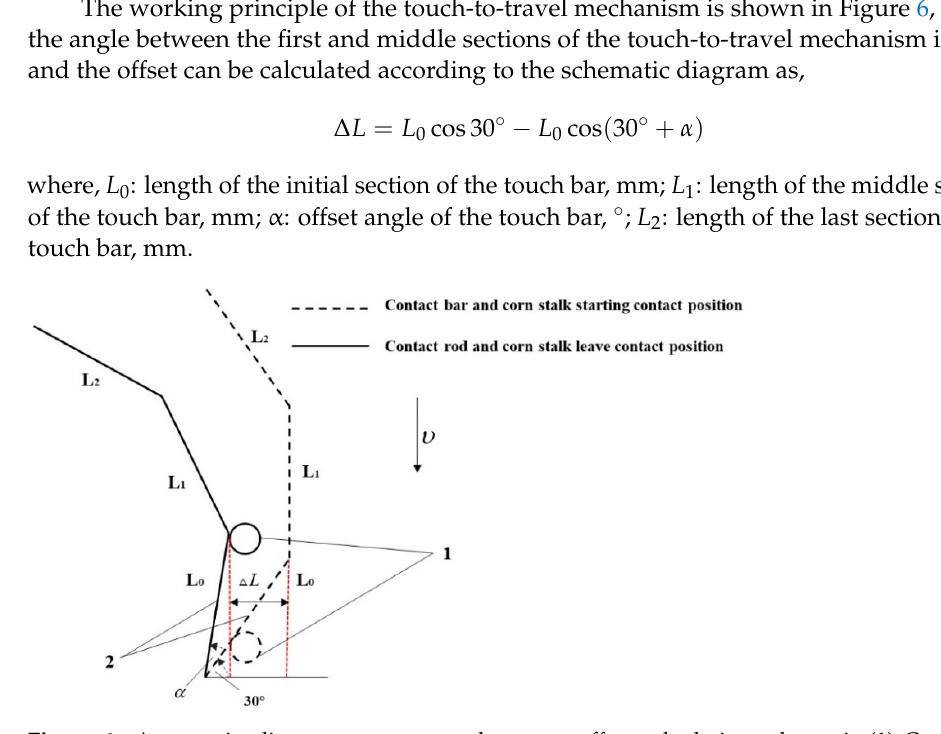
Figure 6. Automatic alignment system angle sensor offset calculation schematic (1) Corn stalk (2) Touching the middle section of the rod.